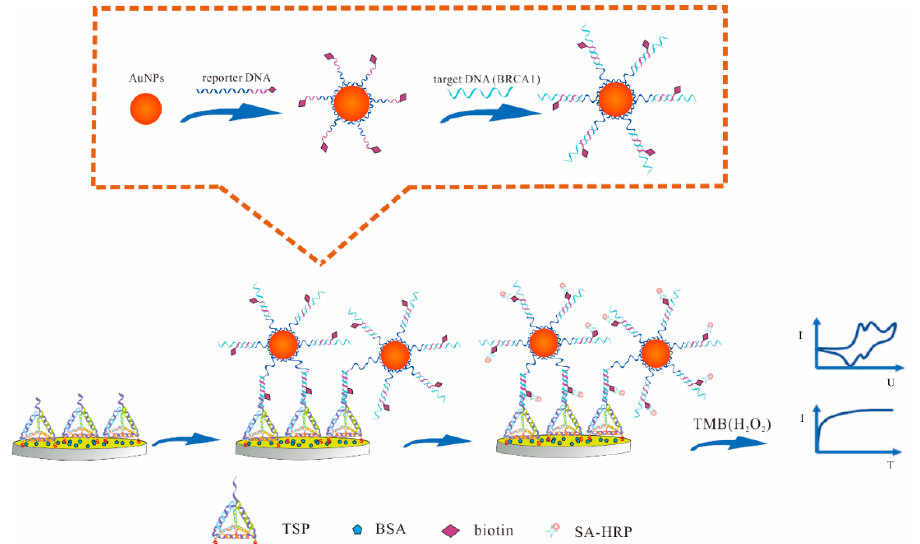
Figure 1. The principle of the development of electrochemical DNA sensor. Cyclic voltammetry (CV curve) and amperometry (IT curve) were applied to investigate the electrochemical behavior of the proposed electrochemical DNA sensor.